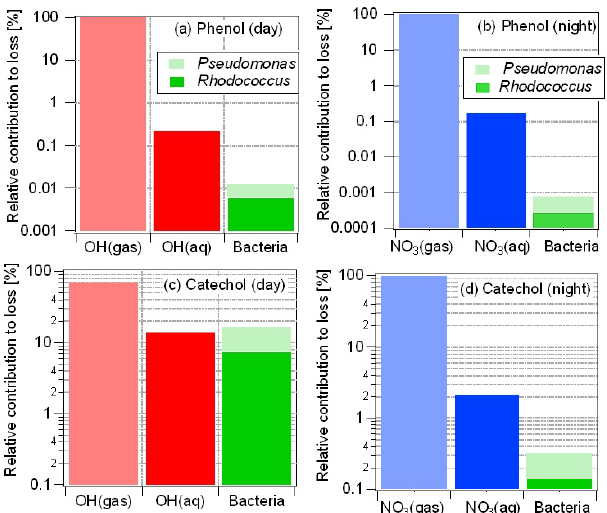
Figure 4. Relative contributions of multiphase processes to total loss of phenol (a, b) and catechol (c, d) during day (a, c) and night (b, d) time. Loss by bacteria processes only occurs in the aqueous phase. Note that the ordinate is shown as a logarithmic scale which might falsely lead to the impression of larger contribu- tions of Rhodococcus compared to Pseudomonas